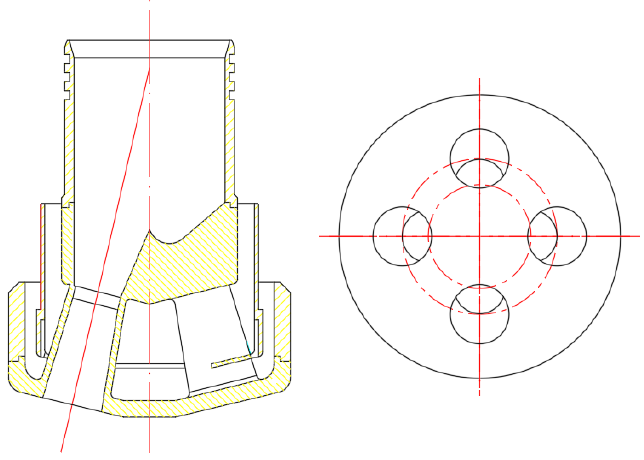
Figure 1. Schematic diagram of a traditional supersonic oxygen lance.